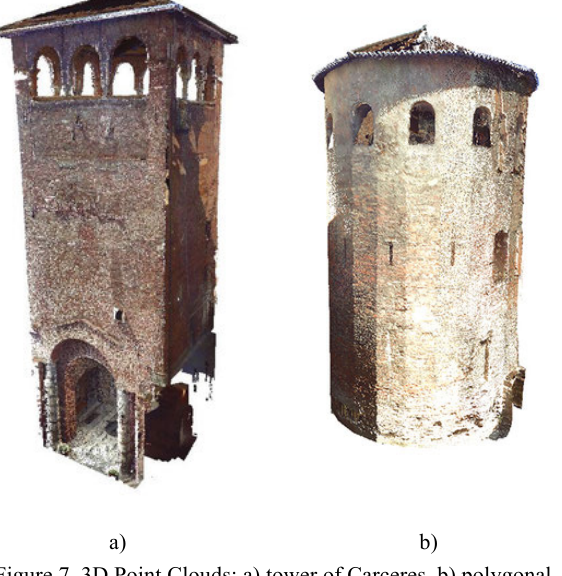
Figure 7. 3D Point Clouds: a) tower of Carceres, b) polygonal tower of city walls adjacent to the circus, still visible in the garden of the Civico Museo Archeologico di